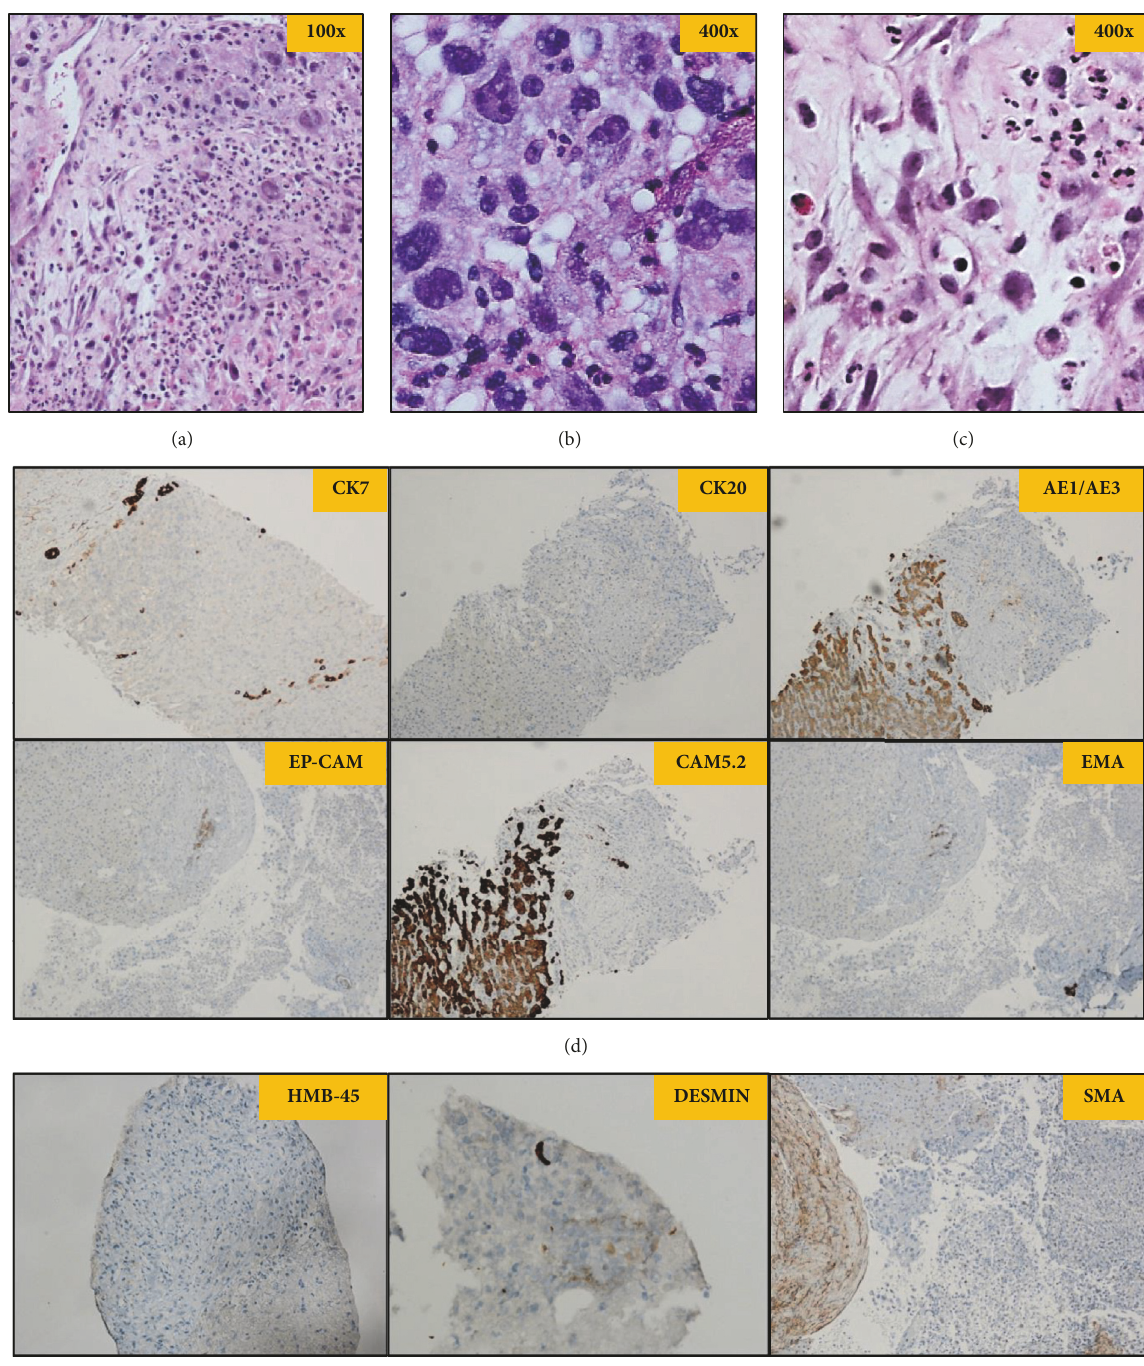
Figure 1: The biopsy showed the tumor was composed of epithelioid to spindle cells infiltrating between hepatocytes with markedly atypical nuclei and prominent necrosis, exhibiting a pleomorphic pattern. (a) Hematoxylin and eosin stain at 100x magnification; (b) and (c) hematoxylin and eosin stain at 400x magnification; (d) Epithelial-Panel staining; (e) other linage staining: HMB-45, desmin, and SMA (the rest of staining not